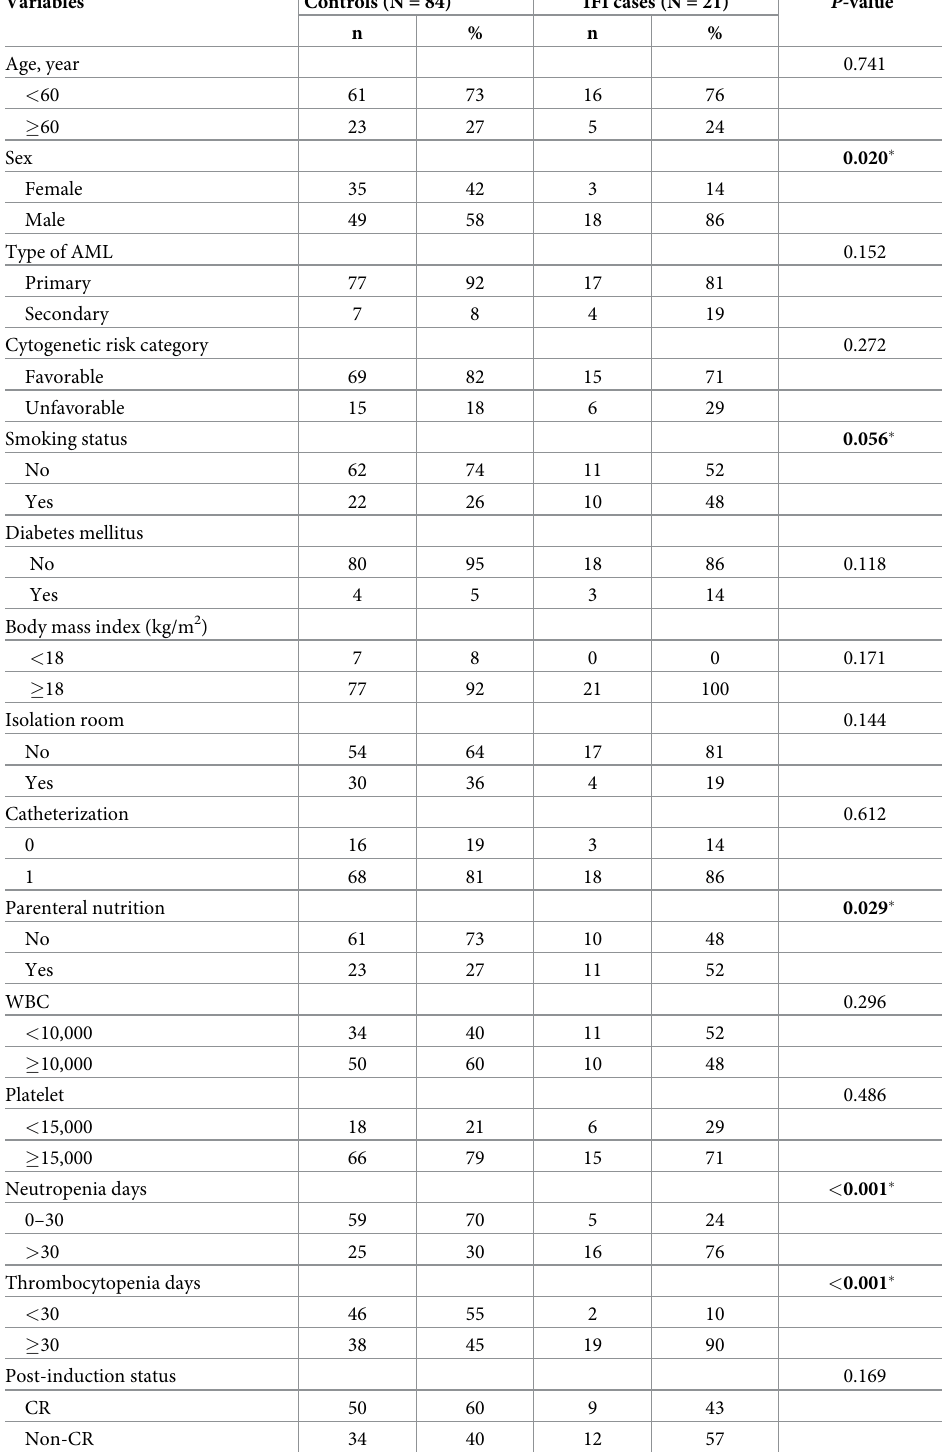
Table 3. Univariate analysis of the risk factors for proven/probable invasive fungal infection (IFI) in 105 Taiwan- ese patients with newly diagnosed acute myeloid leukemia (AML).